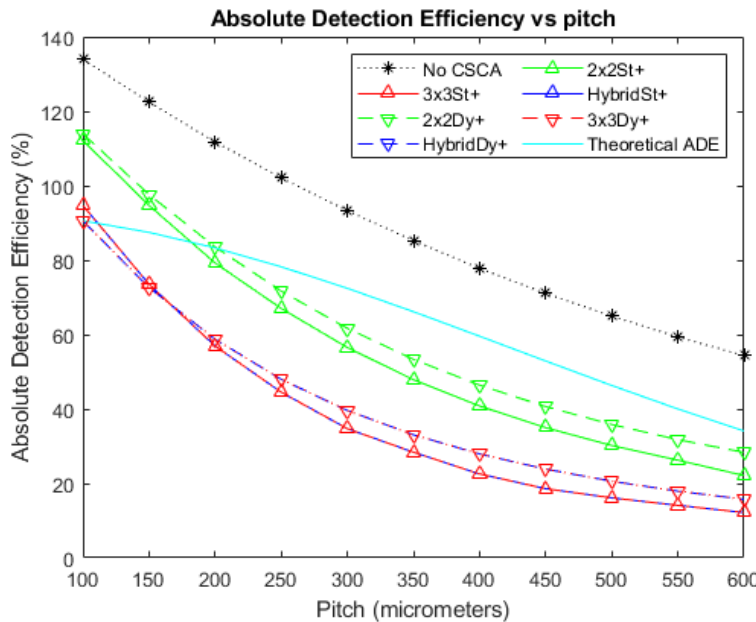
Figure 5. A plot of ADE versus pixel pitch at an incident photon flux of 10 8 photons mm −2 s −1 . The Hybrid and 3 × 3 CSCAs perform indistinguishably according to this metric, resulting in significant overlap. The case where no CSCA is applied is also shown, along with the theoretical ADE value proposed earlier as a reference.